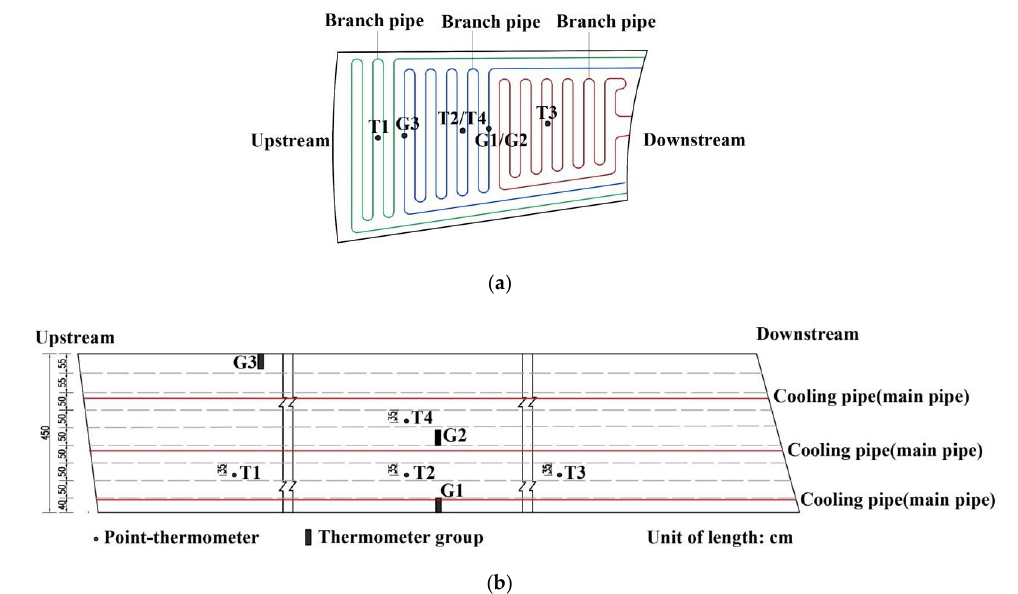
Figure 1. Embedded positions of thermometers and cooling pipes: ( a ) layout of thermometers and branch pipes; ( b ) vertical distribution of thermometers and main pipes.